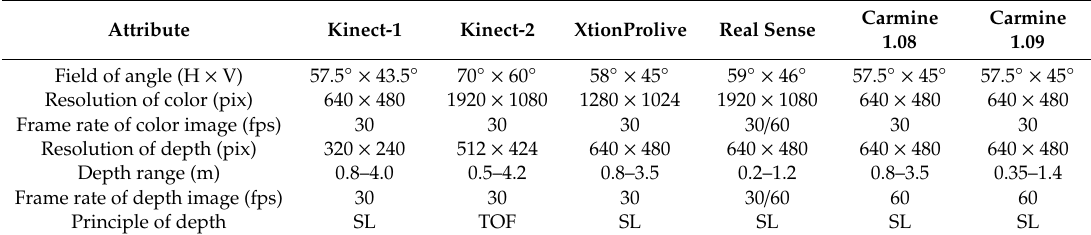
Figure 1. Intrinsic structure of Kinect:Kinect-1 (left) and Kinect-2 (right). Table 1. Configuration parameters of RGB-D cameras.